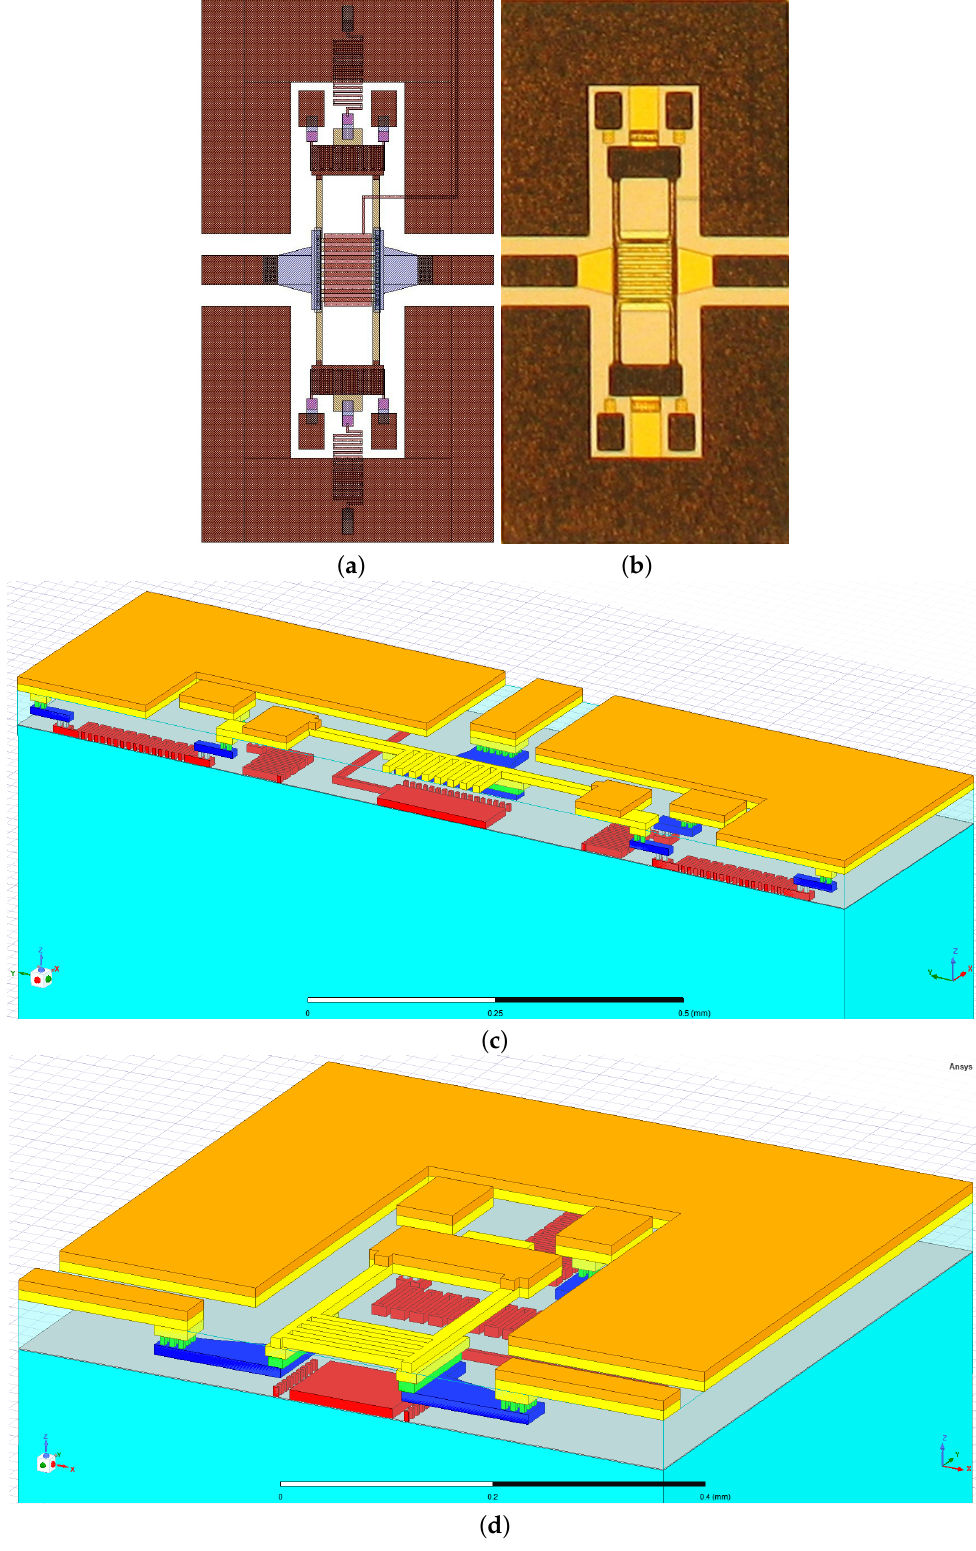
Figure 5. RF-MEMS switch employed in the proposed pseudohairpin bandpass filter: ( a ) complete layout, ( b ) fabricated sample, ( c ) vertical and ( d ) horizontal cross sections of the 3D model in Ansys HFSS